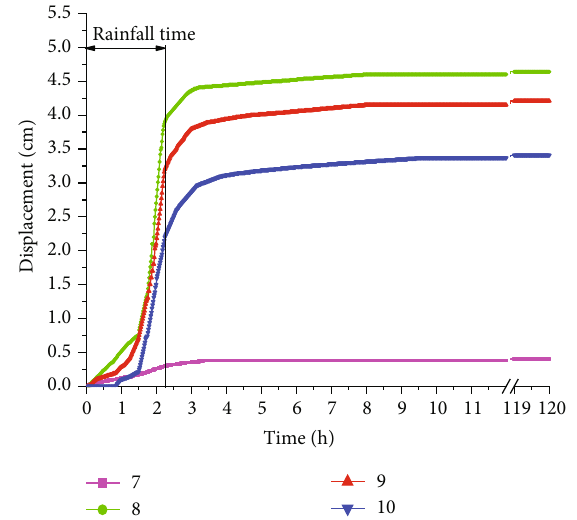
Figure 16: The changes of the displacement of the tunnel vault with